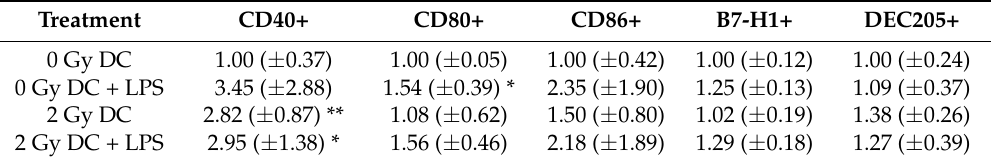
Table 1. Relative changes in the phenotype of splenic DCs irradiated with 2 Gy and/or treated with lipopolysaccharide (LPS) compared to control mice 3 days after irradiation. Data represent the average of four independent experiments (2–4 animals for each experiment) for each dose point. Significance compared to 0 Gy DC was tested by Student’s t -test (* p < 0.05, ** p < 0.01). Treatment CD40+ CD80+